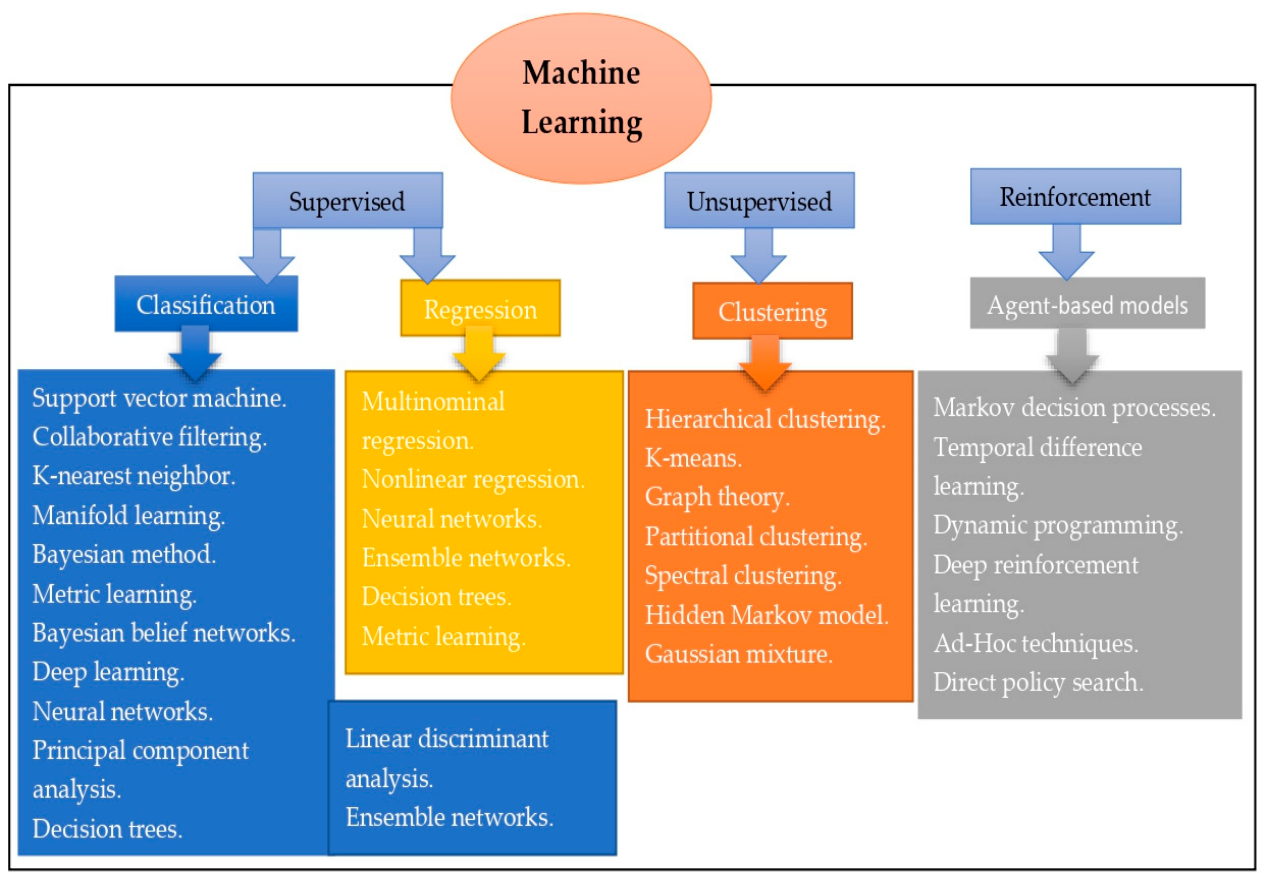
Figure 8. Machine learning categories and algorithms.